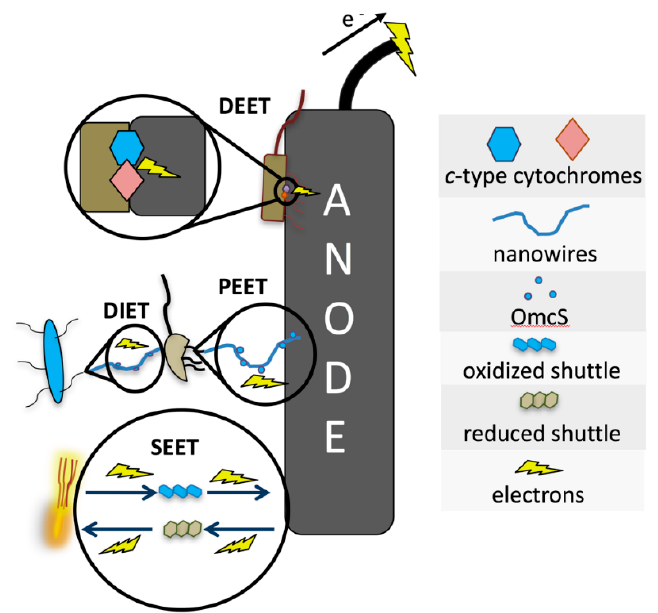
Figure 1. Mechanisms of interaction of electroactive microorganisms (EAMs) with the anode of microbial electrochemical systems (MESs) include direct extracellular electron transfer (DEET) through membrane bound cytochromes, PEET by using electroconductive pili, the use of soluble electron shuttles (SEET), and interactions between different species, directly transferring electrons between one another